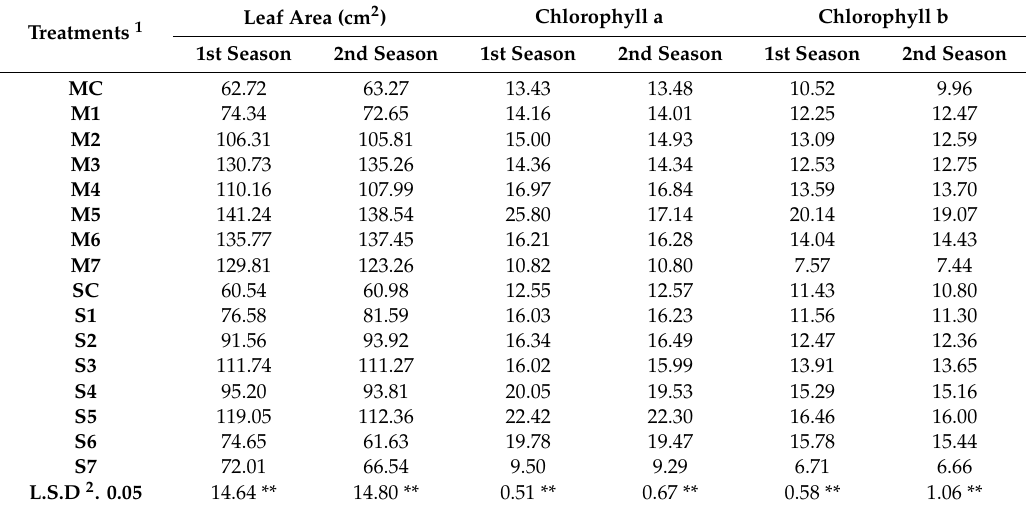
Table 5. E ff ect of spent mushroom substrate extract (SMSE), mushroom culture filtrate (MCF), and Roundup ® treatments to control broomrape infestation on leaf area (cm 2 ), chlorophyll a and chlorophyll b of faba bean plants at 60 days from sowing during two